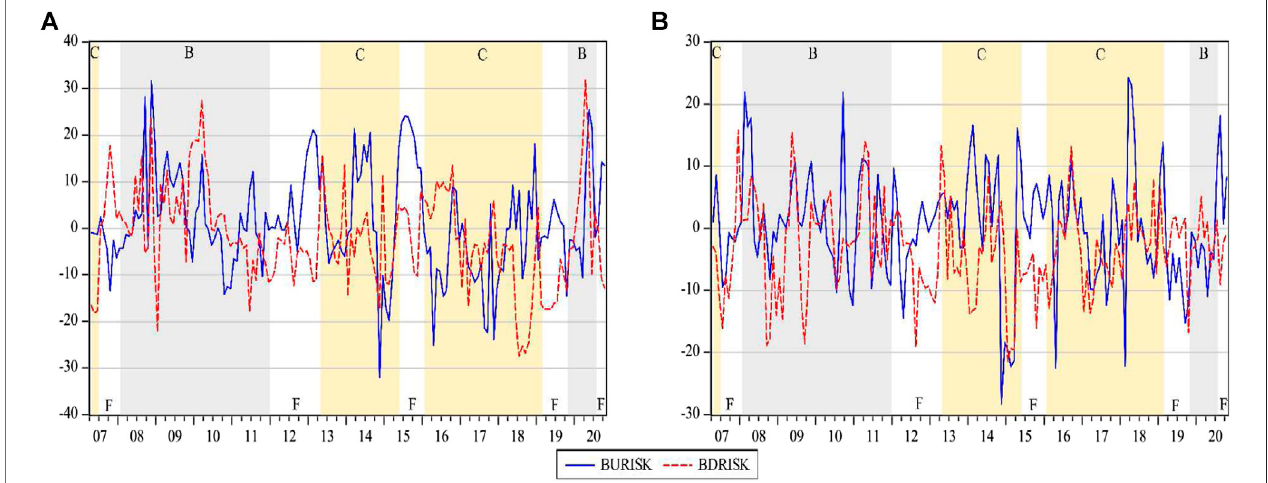
FIGURE4| Riskspilloverbetweentheinternational crudeoilmarketandcommoditymarketor fi nancialmarket. (A) Riskspilloverindexoftheinternationalcrudeoil market and commodity market. (B) Risk spillover index of the international crude oil market and fi nancial market. BURISK and BDRISK represent the upside risk and downside risk respectively. CRISK is the commodity market risk. FRISK is the fi nancial market risk. B means that the dual attributes of crude oil are dominant. C means that the commodity attribute of crude oil is dominant. F means that the fi nancial attribute is dominant.